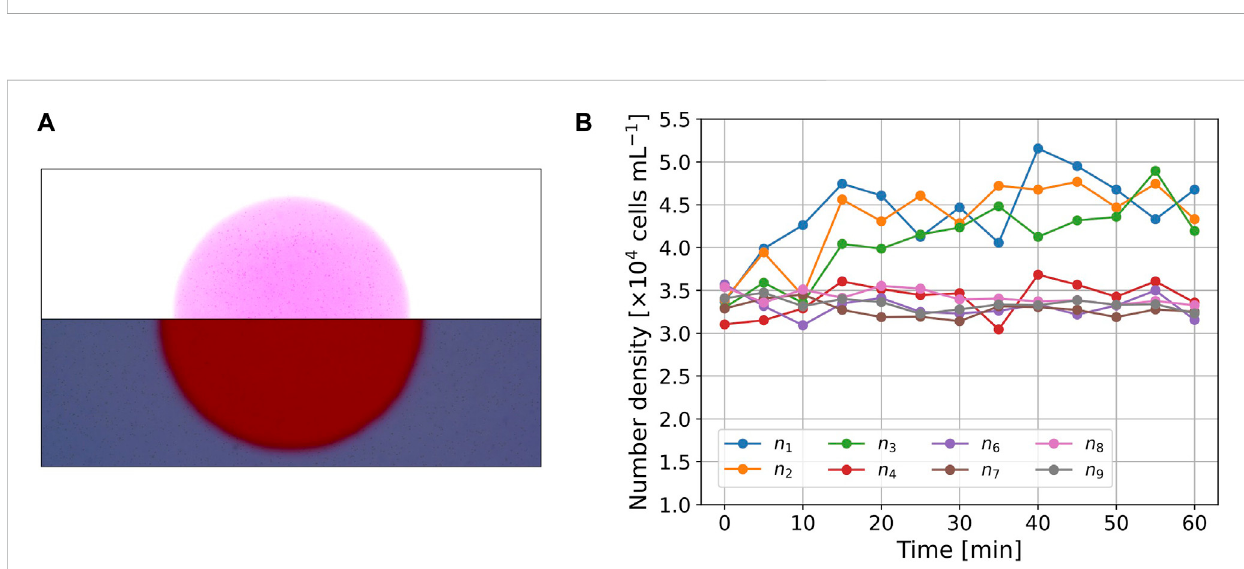
FIGURE 2 (A) Images of the cell distribution ( t =30 min). The picture was divided into upper and lower parts, both of which were modi fi ed independently to visualize the cells for presentation purposes. (B) Time series of number density n k ( t ) in the subregions.